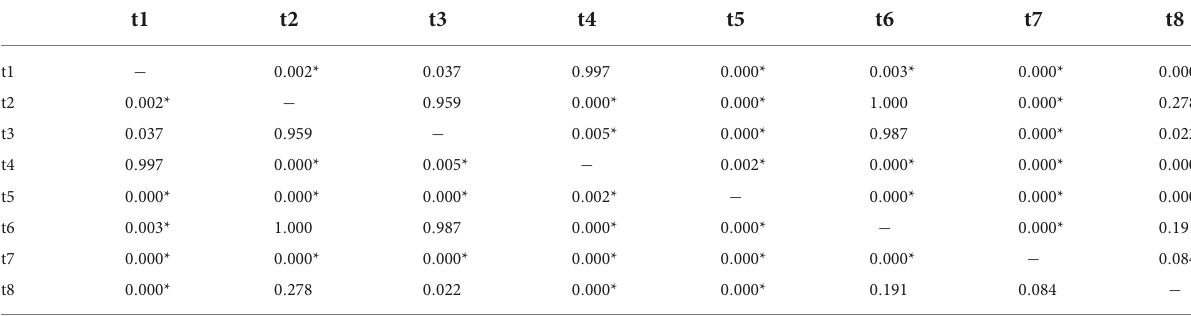
TABLE 6 Pairwise comparison of the treatments for total phenolics by Scheffe post hoc